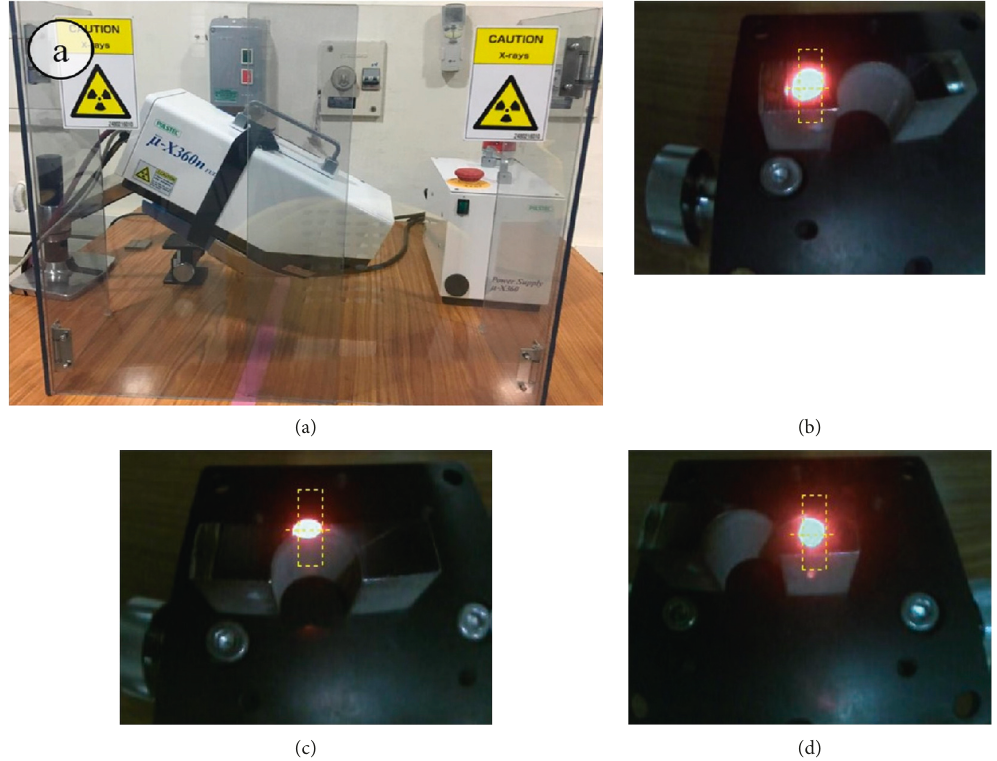
Figure 6: Residual stress analyzer (a) and camera image of measuring surface (b, c, and